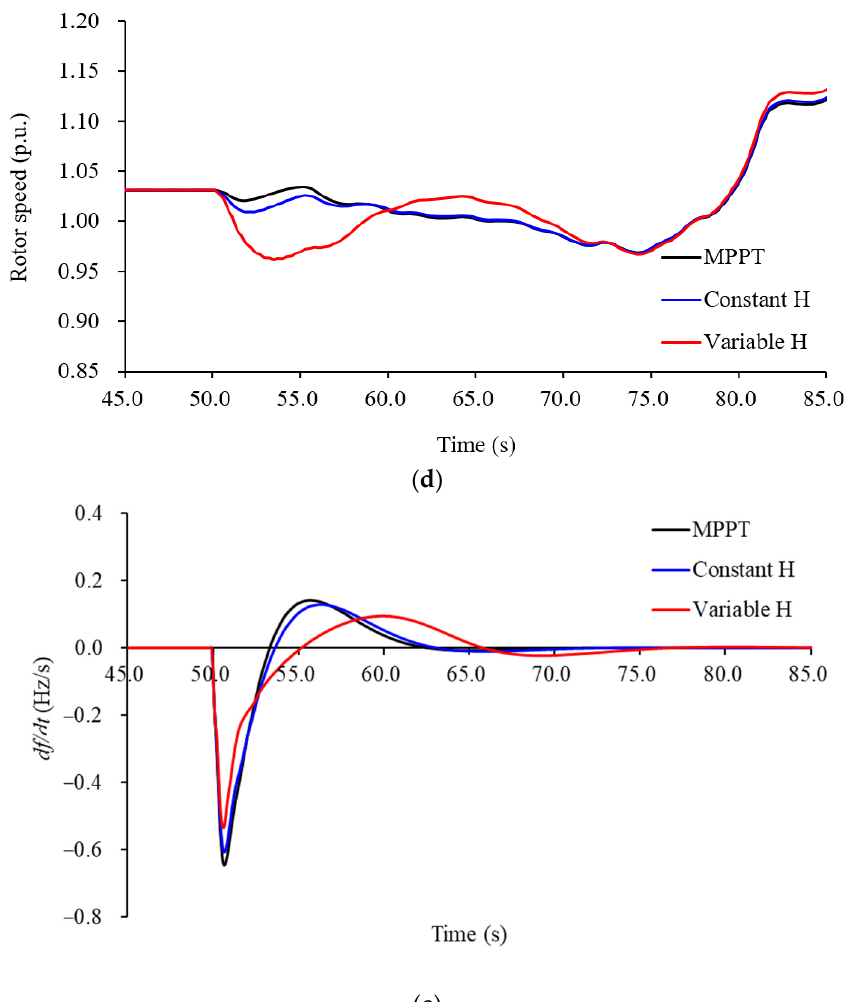
Figure 9. Results for Case 3: ( a ) wind speed; ( b ) system frequency; ( c ) output power; ( d ) rotor speed; ( e ) rate of change of frequency. Table 1. Comparison indices including frequency nadirs and maximum ROCOFs for all cases.